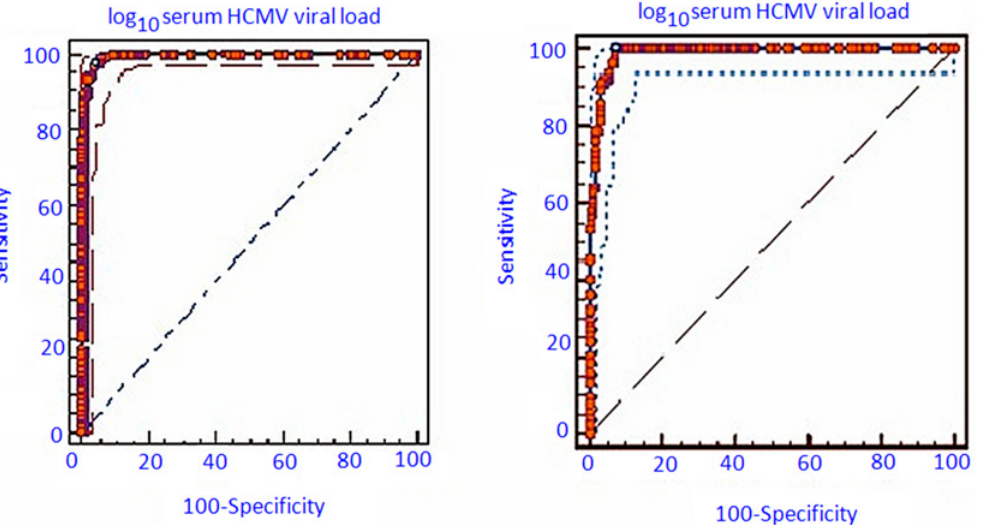
Fig 3. ROC curve for determining the cut-off value of serum CMV viral load for the development of (i) CMV end organ diseases (EODs) (left) and (ii) Disseminated CMV EODs (right).